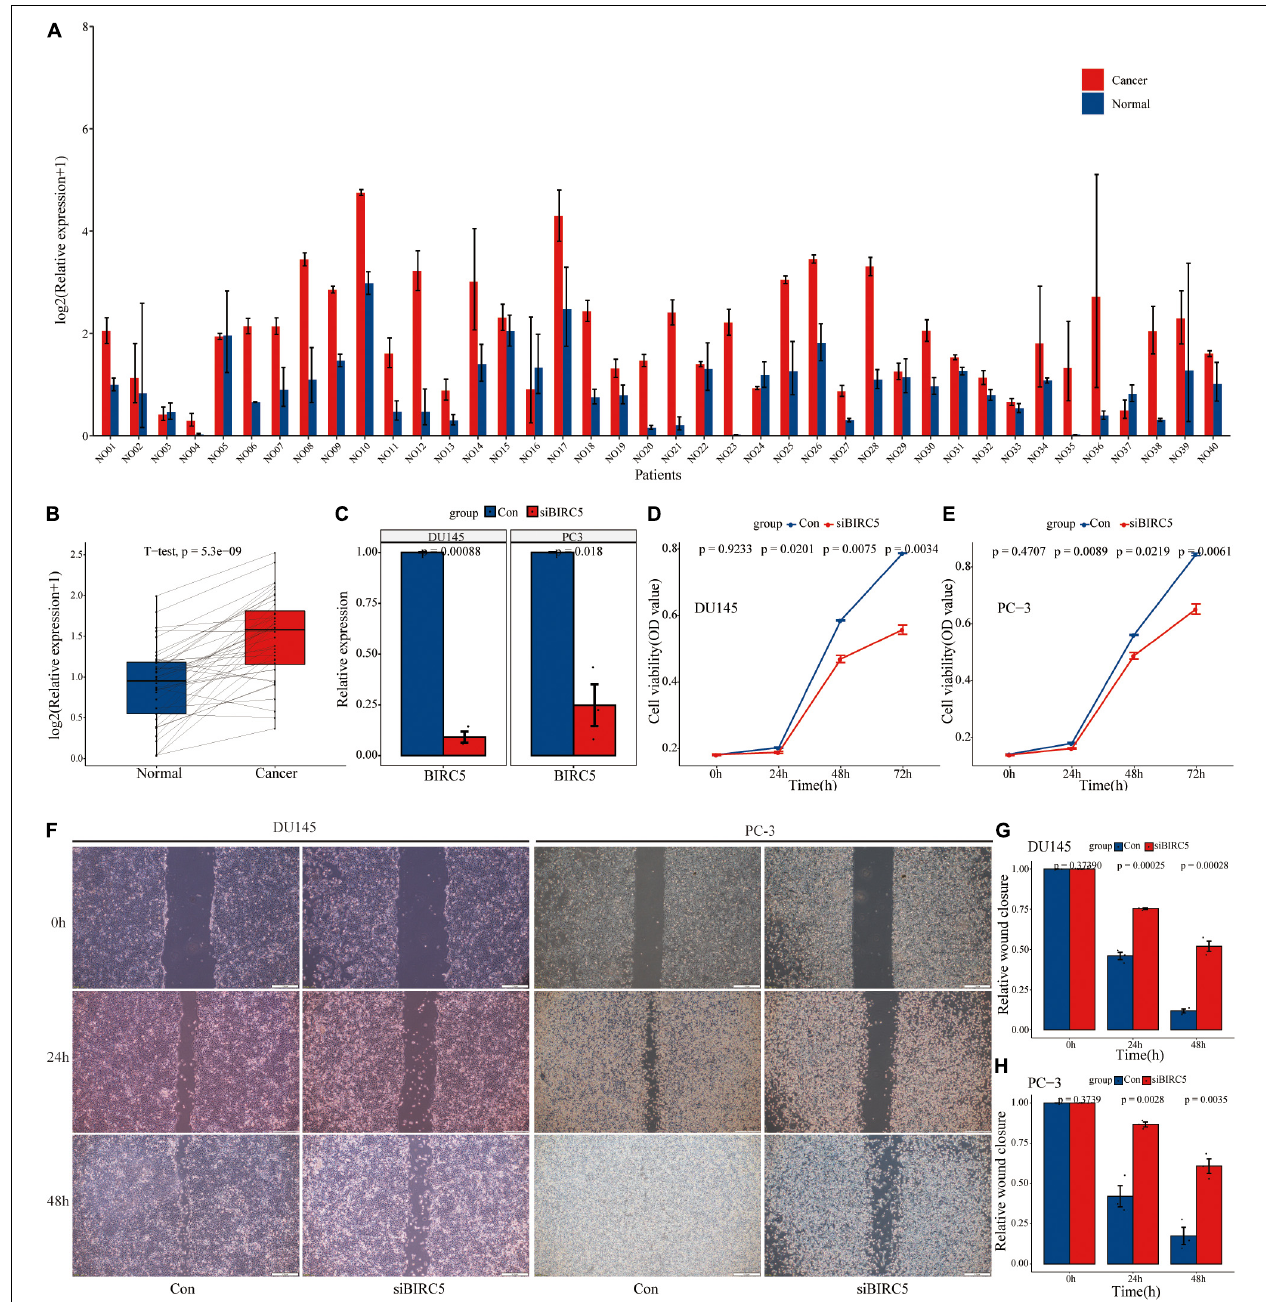
FIGURE 12 | The level of BIRC5 expression in PCa tissues and its biological function. (A,B) The expression level of BIRC5 in 40 pairs of PCa and normal matched tissues; (C) RT-qPCR analysis for the transfection efficiency of BIRC5-siRNA in PC-3 and DU145 PCa cells; (D–E) CCK-8 assay for the proliferation of PC-3 and DU145 PCa cells after BIRC5 silencing; (F–H) Wound healing assays for the migration of PC-3 and DU145 PCa cells after BIRC5